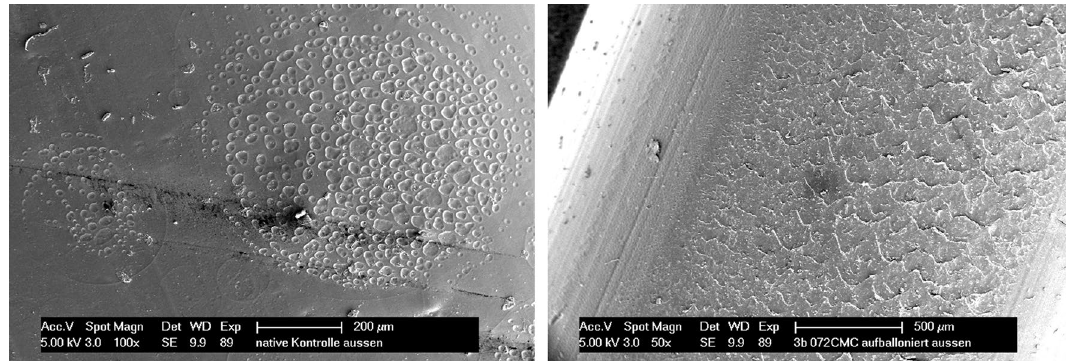
Figure 4. Scanning electron microscopic assessment shows cornfield pattern at the inner surface (left) and scale structure on the outside